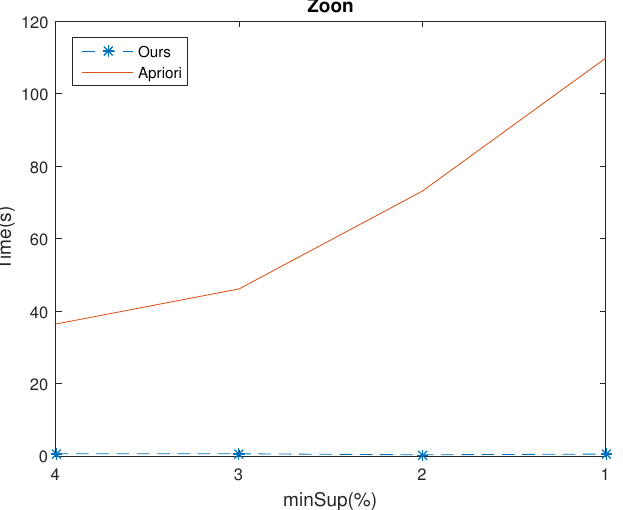
Figure 7. Execution time of the two algorithms in Zoon dataset for various minSup